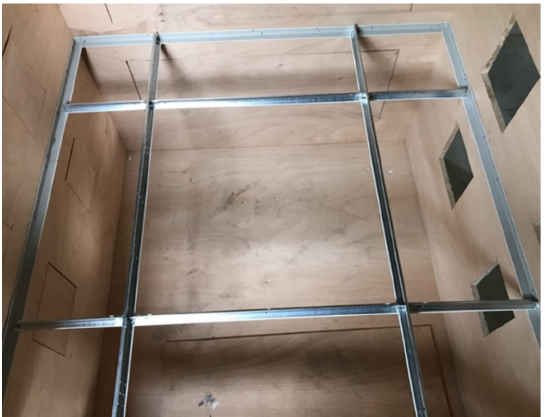
Figure 2. Test equipment composition.